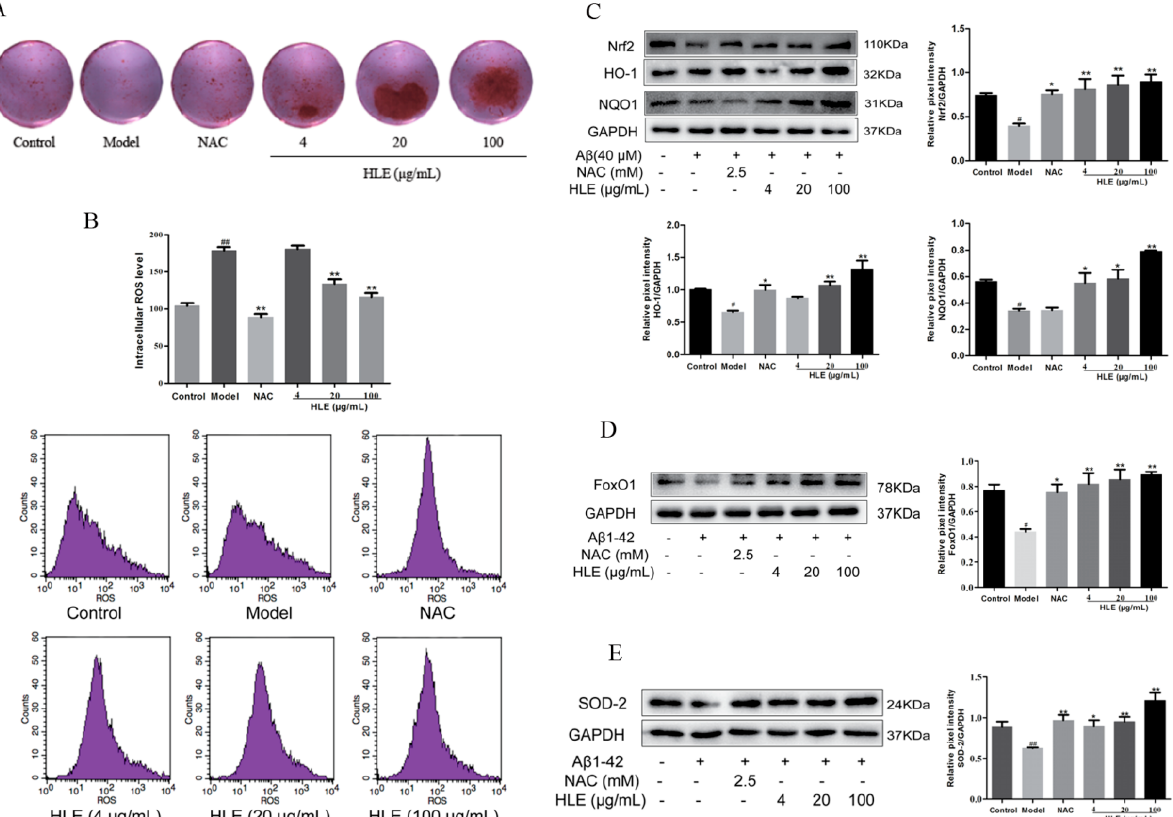
Figure 6. Effects of HLE on bone formation and oxidative stress in A β -injured osteoblastic MC3T3-E1 cells. ( A ) The bone mineralization nodule determined by Alizarin red staining; ( B ) intracellular ROS levels determined by flow cytometry; ( C – E ) relative expression of Nrf2, HO-1, NQO1, FxoO1 and SOD-2 determined by Western blotting ( n = 3). (# p < 0.05, ## p < 0.01, compared with the CON group; * p < 0.05, ** p < 0.01 compared with the model group. Model group means osteoblasts only treated with A β . )